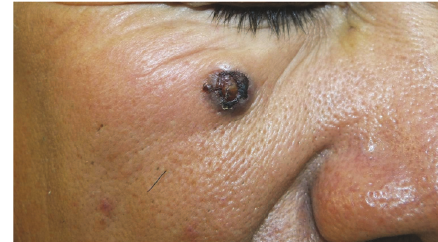
Figure 1: Clinical image of lesion. A purple nodule, located on the right cheek, with a diameter of 1.5cm and an ulcerated center and surrounded by hematic crust having slightly raised edges and a firm consistency.